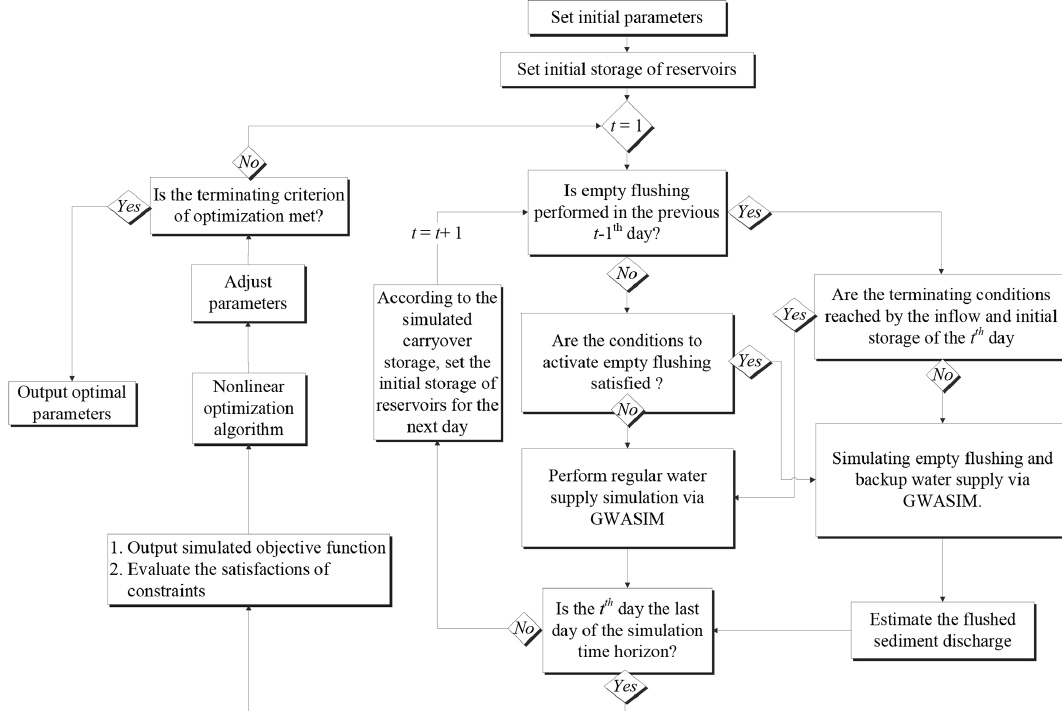
Figure 6. The procedure to derive the optimal empty flushing strategy.